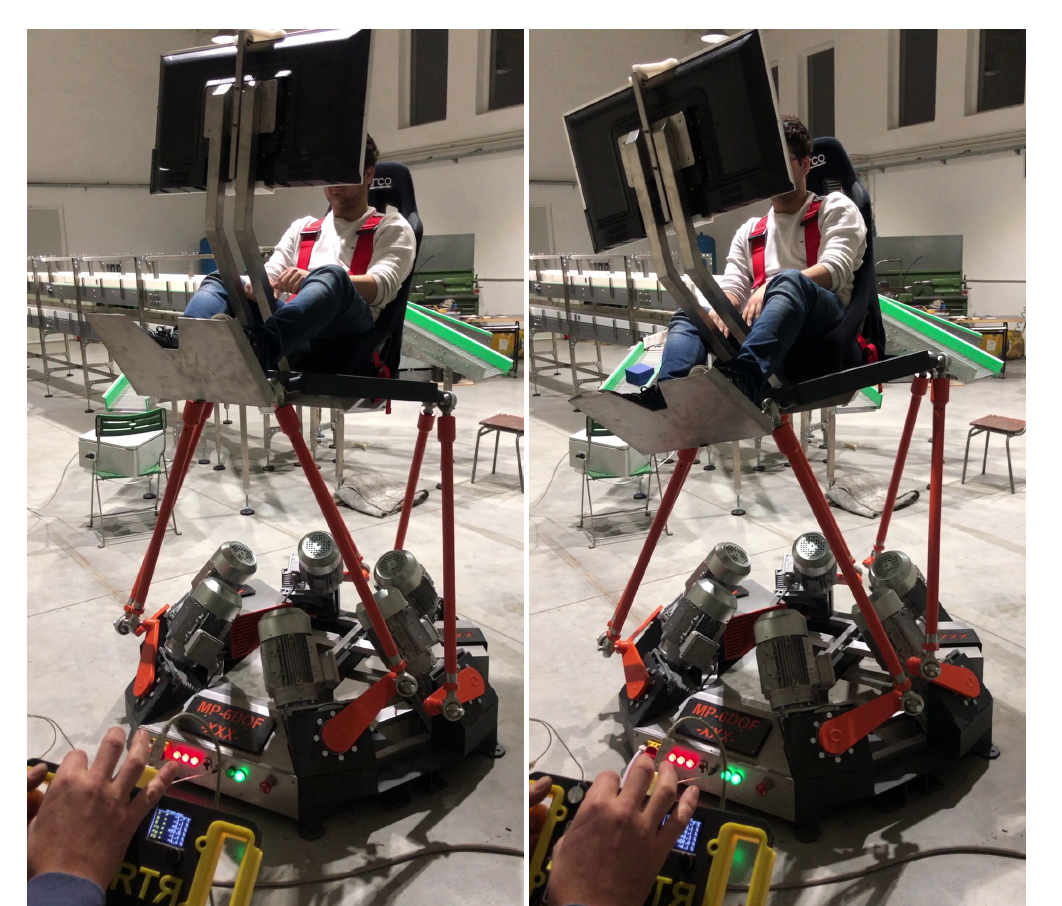
Figure 20. Experiment with a prototype of an optimized flight simulator